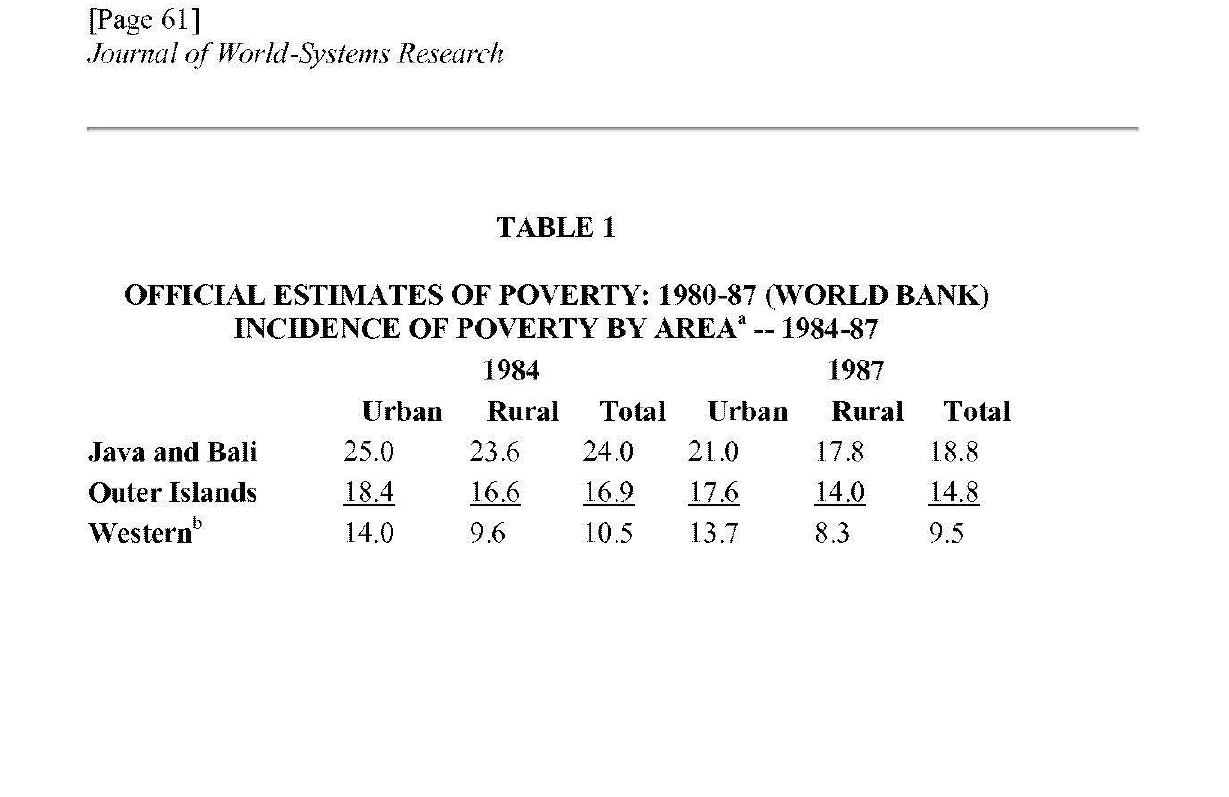
OFFICIAL ESTIMATES OF POVERTY: 1980-87 (WORLD BANK) INCIDENCE OF POVERTY BY AREA a --